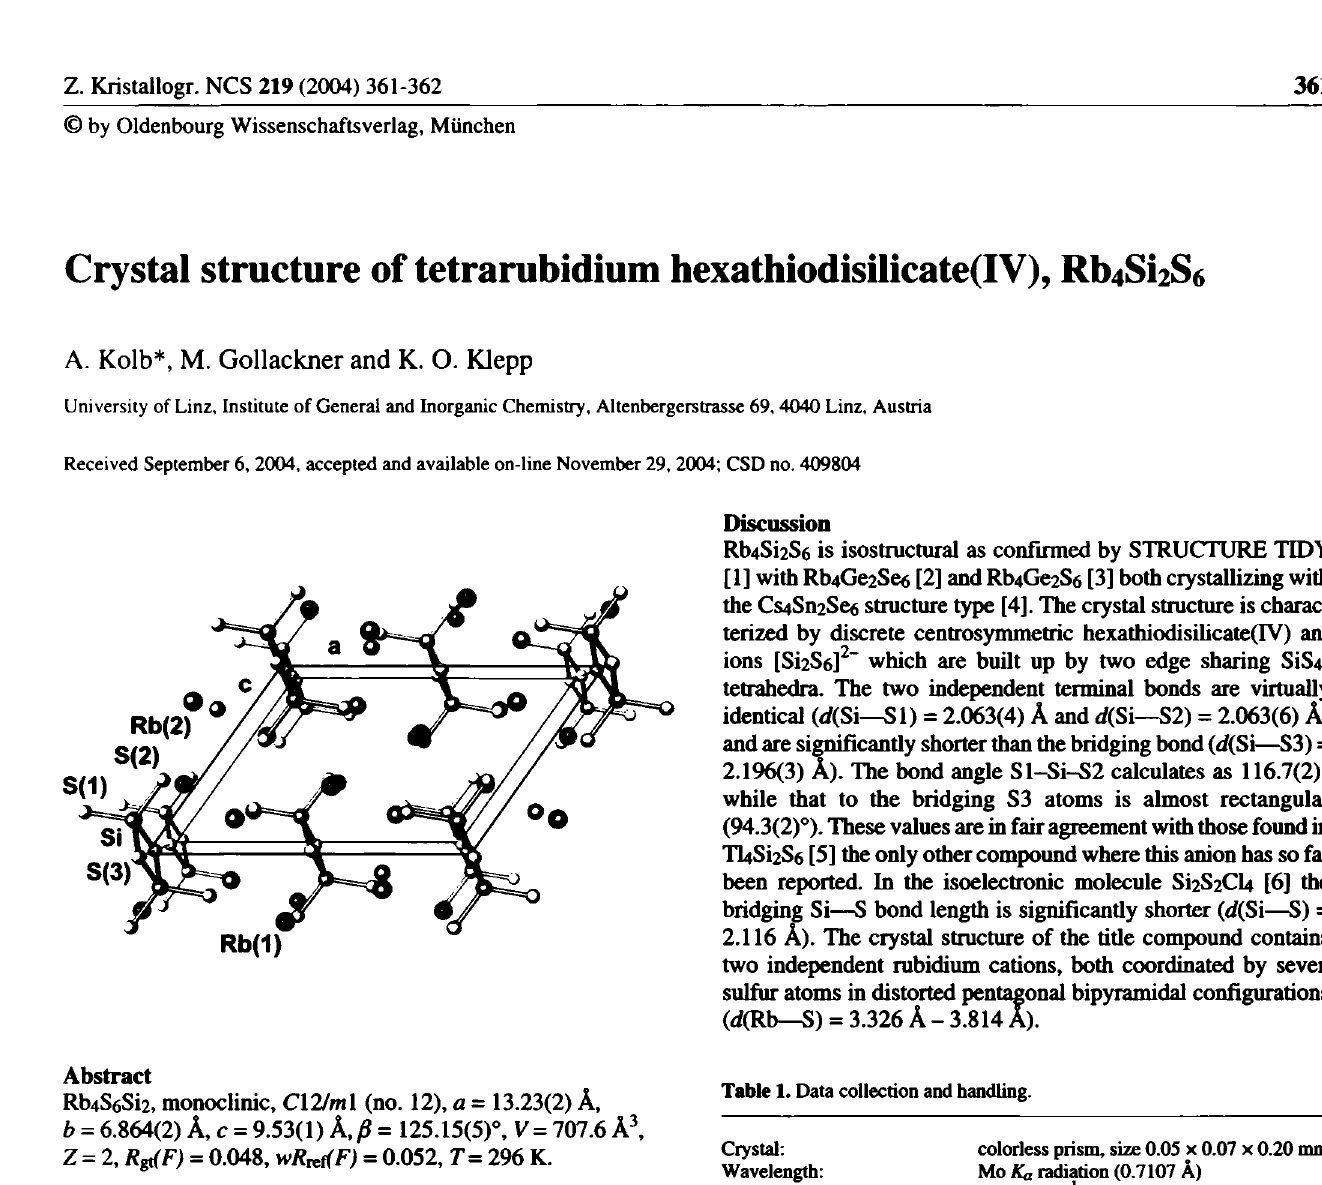
Table 1. Data collection and handling.